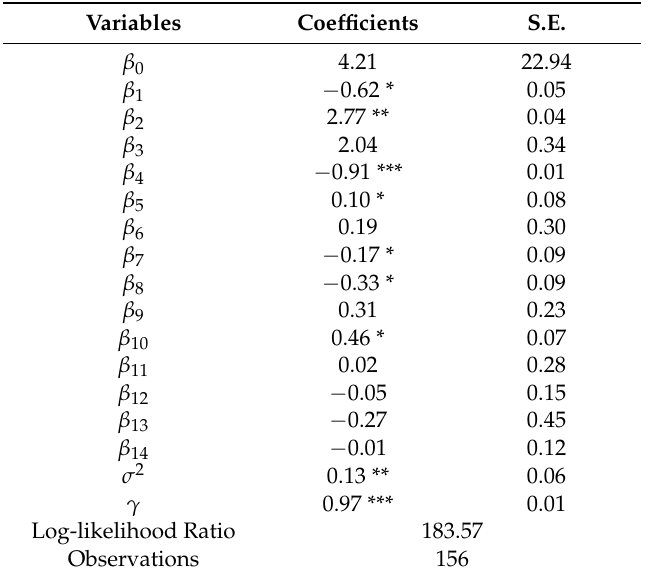
Table 2. The estimated Translog production